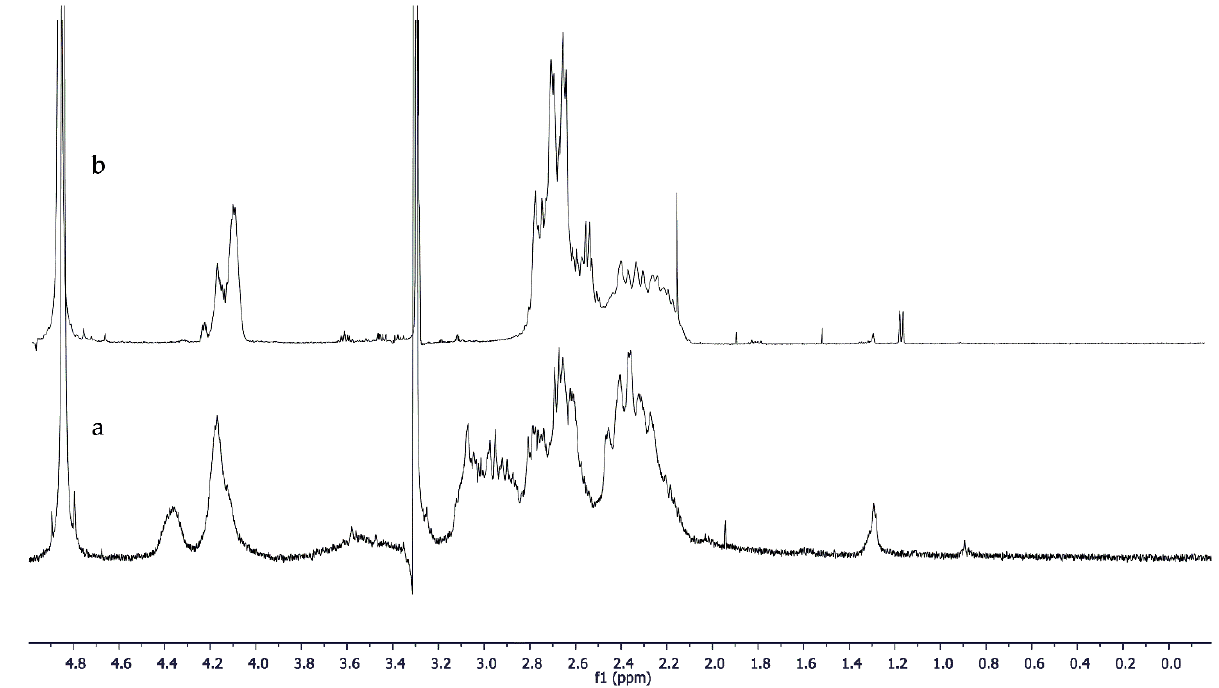
Figure 12. 1 H NMR spectra of DF after ( a ) and before ( b ) aging.